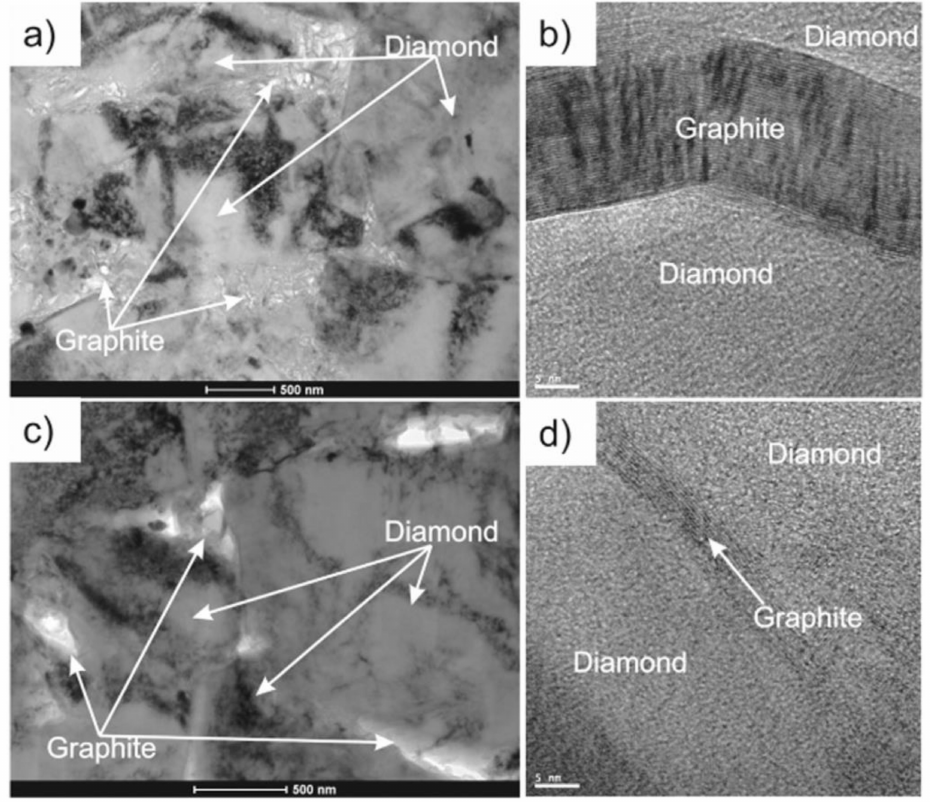
Figure 10. Microscopic images of the samples with 90 wt% diamond +10 wt% (Ti+ 2B). TEM image ( a ) and HREM image ( b ) of diamond composite sintered with classical HP–HT technique. TEM image ( c ) and HREM image ( d ) of diamond composite sintered with HP-SPS technique (from